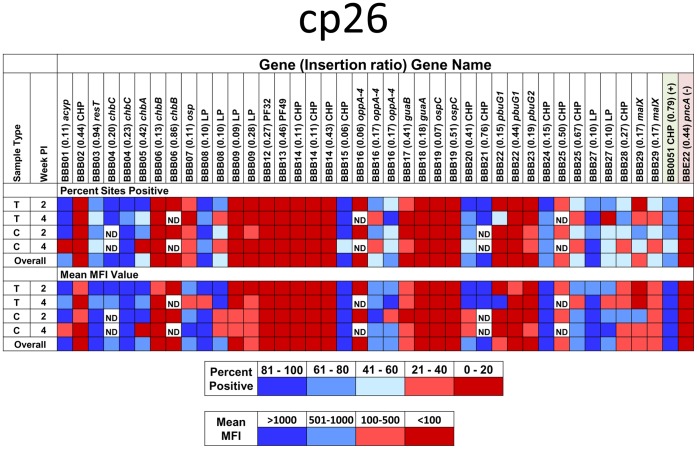
A simple heat map representation of the mouse infectivity of transposon mutants in cp26 genes.For each clone, results from Luminex STM analysis (see Fig. 4, Table 3 in File S1) were grouped by week post inoculation (2 weeks or 4 weeks) and by DNA preparation method (Culture  =  use of organisms cultured from tissue; Tissue  =  use of DNA extracted directly from tissue). The data in each group were scored according to the percentage of samples with MFI values above the negative threshold (100) or to the mean MFI value; each result was then color coded as indicated in the key. Each colored box in the figure corresponds to 12 to 15 data points (typically 5 tissues from 3 mice). Heat maps for other plasmids and gene function groups are provided in Figs. S7 and S8. The composite results obtained in all experiments for the positive (bb0051) and negative (pncA) control mutants are provided at the right side of the figure. Abbreviations are as described in the Figure 4 legend.